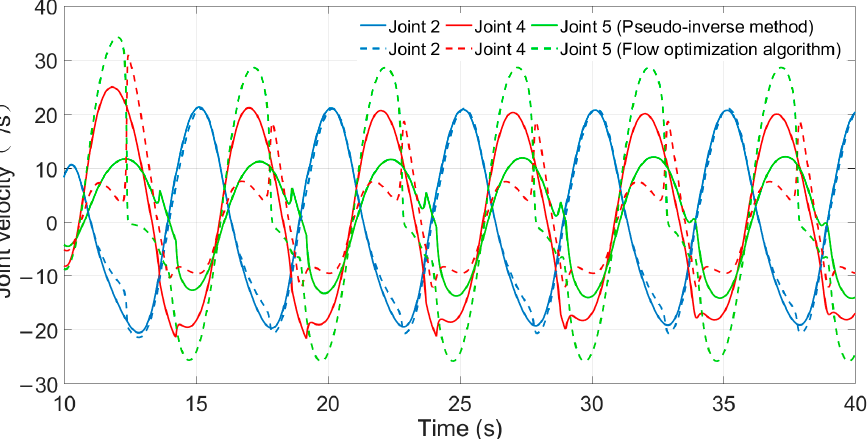
Figure 8. The desired joint velocity calculated according to the pseudo-inverse method and the flow optimization algorithm in the experiments.